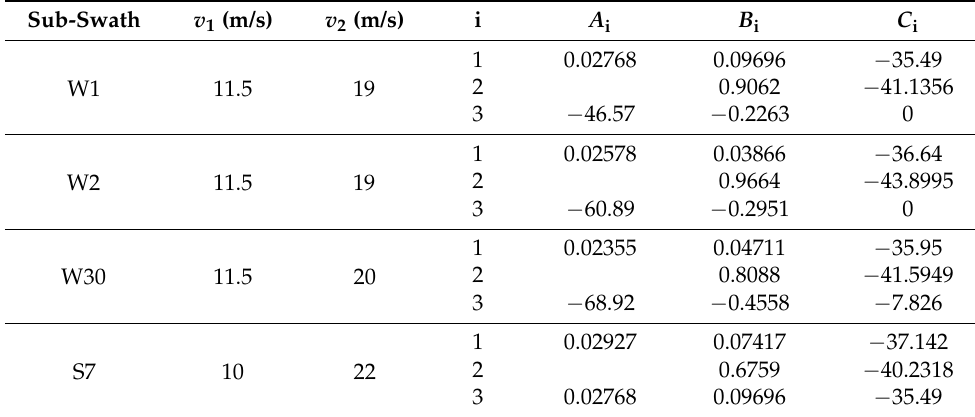
Table 2. List of the coefficients in Equation